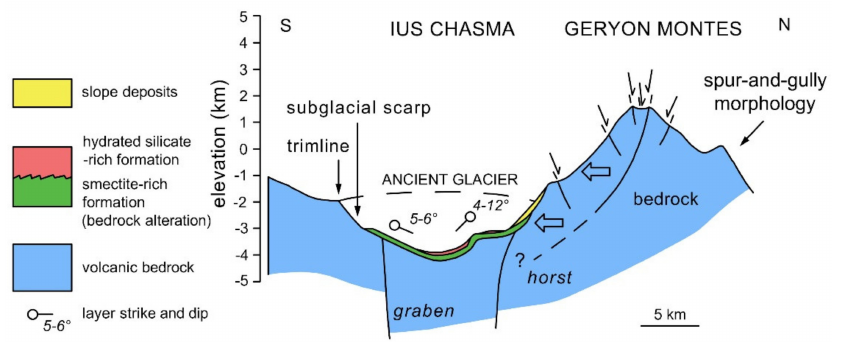
Figure 4. Model of development of ridge-top splitting and uphill-facing scarps along N-S cross- section in Ius Chasma; redrawn after M è ge and Bourgeois [60]. The glaciation is marked by trimline, subglacial scarp, and hydrated silicate- and smectite-rich formation; the glacier retreat produces slope debuttressing and consequent triggering of large-scale gravitational